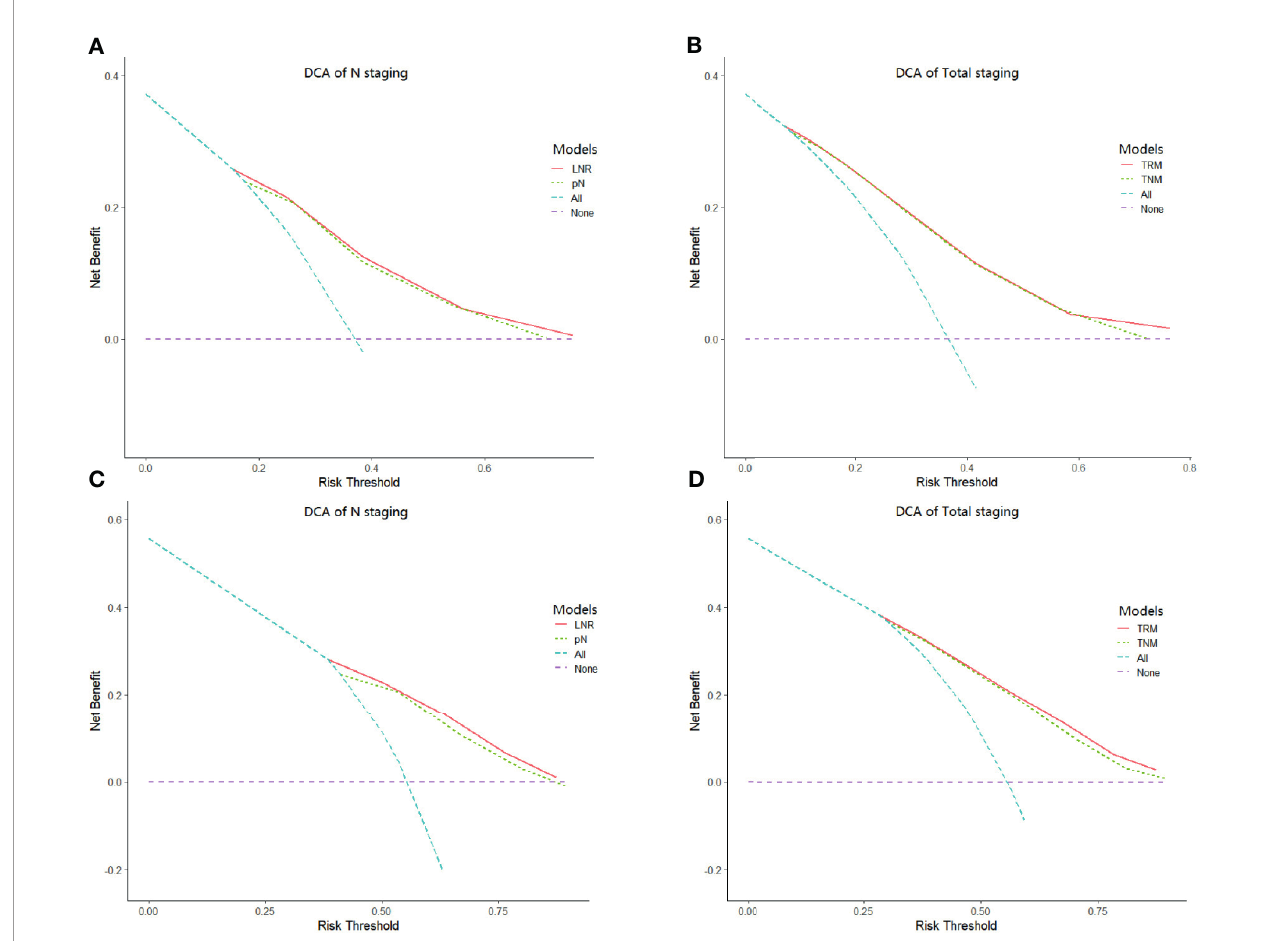
FIGURE 3 | Results of decision curve analysis. Results of decision curve analysis pN vs LNR (A) and TNM vs TRM (B) in the training set; pN vs LNR (C) and TNM vs TRM (D) in the validation